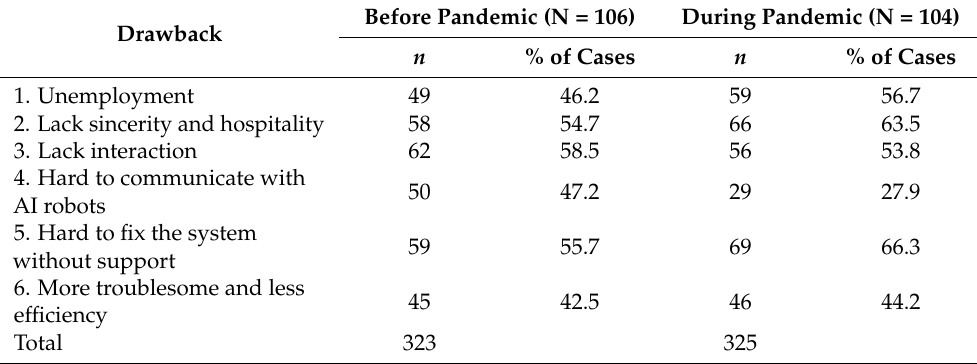
Table 6. Perceived drawbacks of Generation Z hotel employees by different